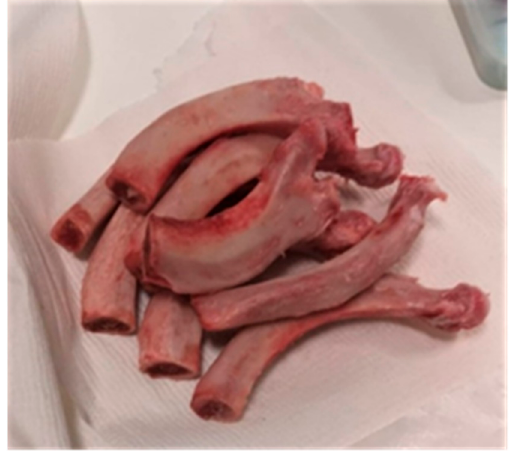
Figure 1. Porcine ribs used for the study.